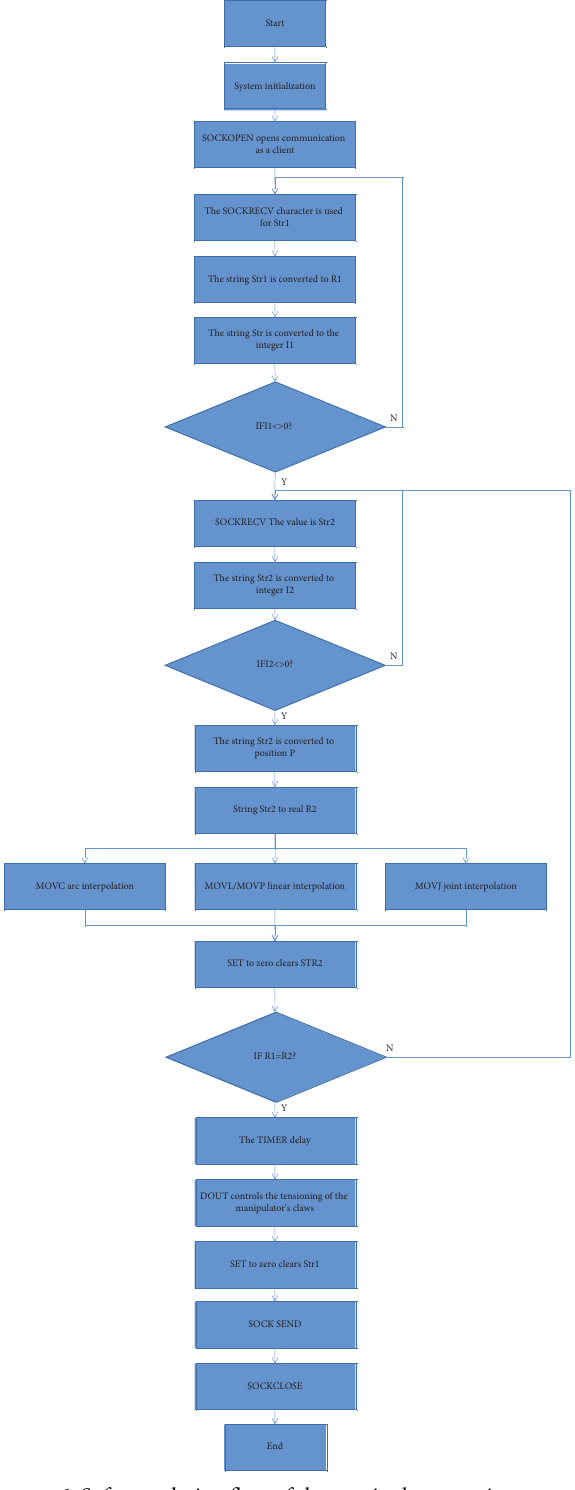
Figure 6: Software design fow of the manipulator motion control module.